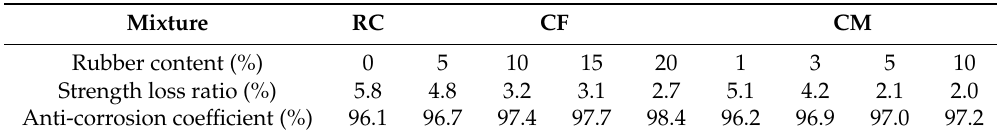
Figure 6. Freezing-thawing of crumb rubber concrete. Table 3. Durability of crumb rubber